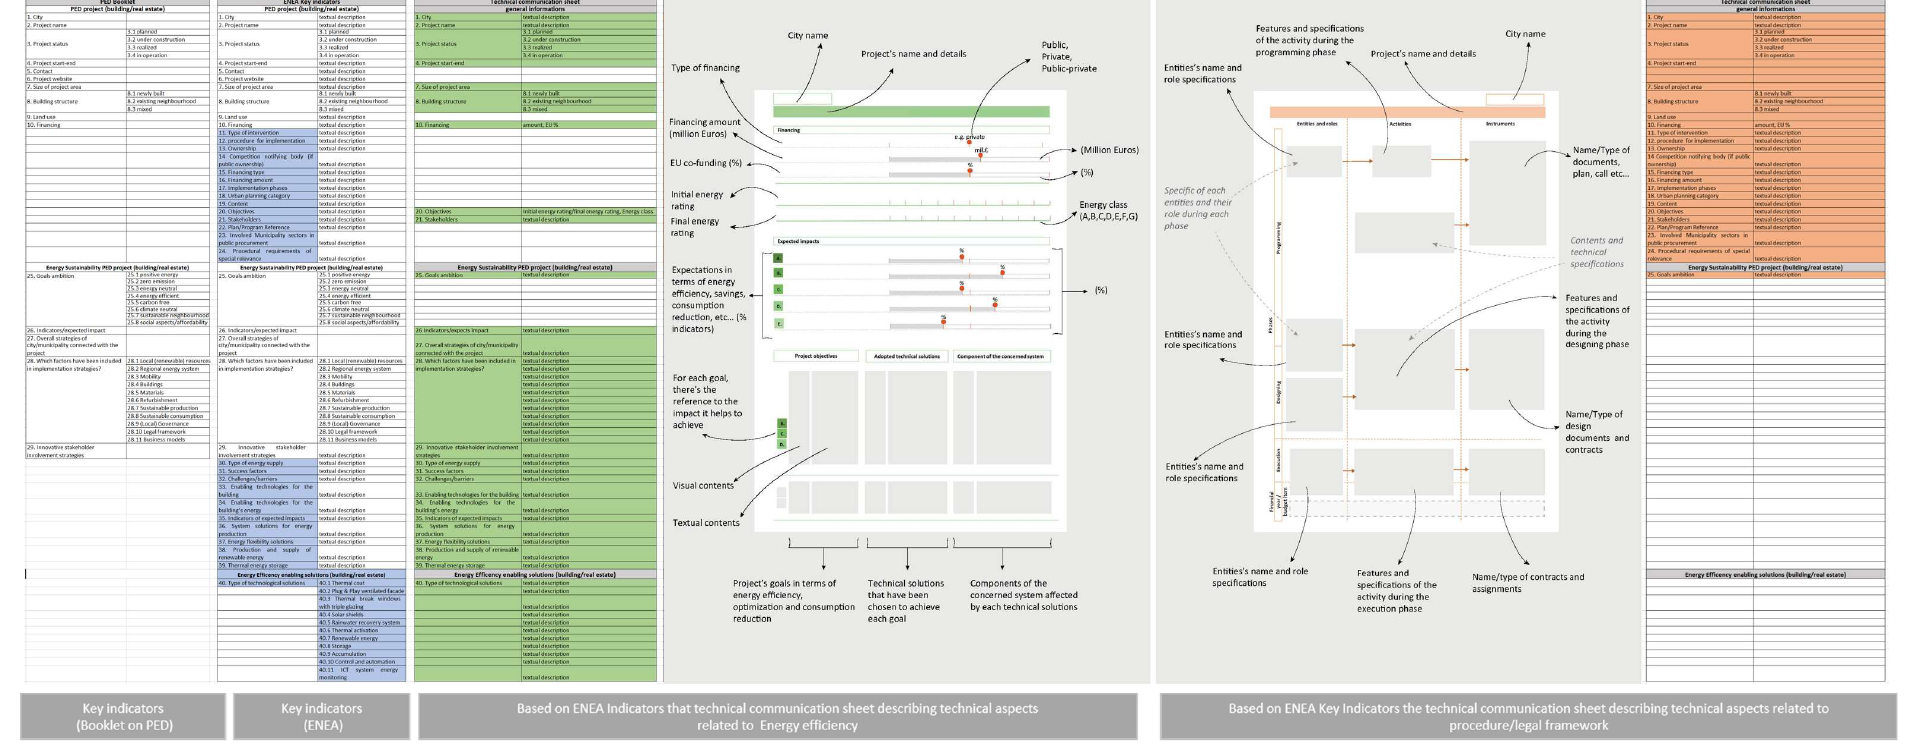
Figure 4. Comparison of a technical data sheet and a technical communication sheet.